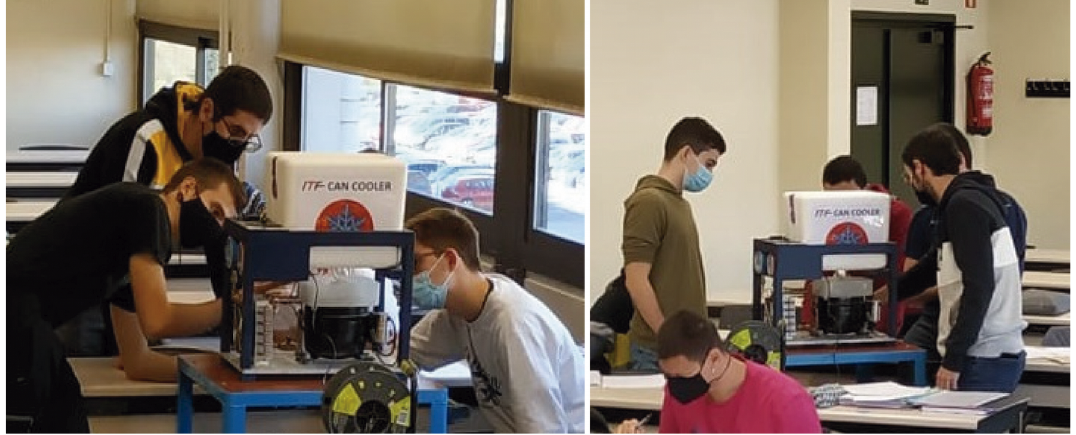
Figure 9. Pictures of the laboratory